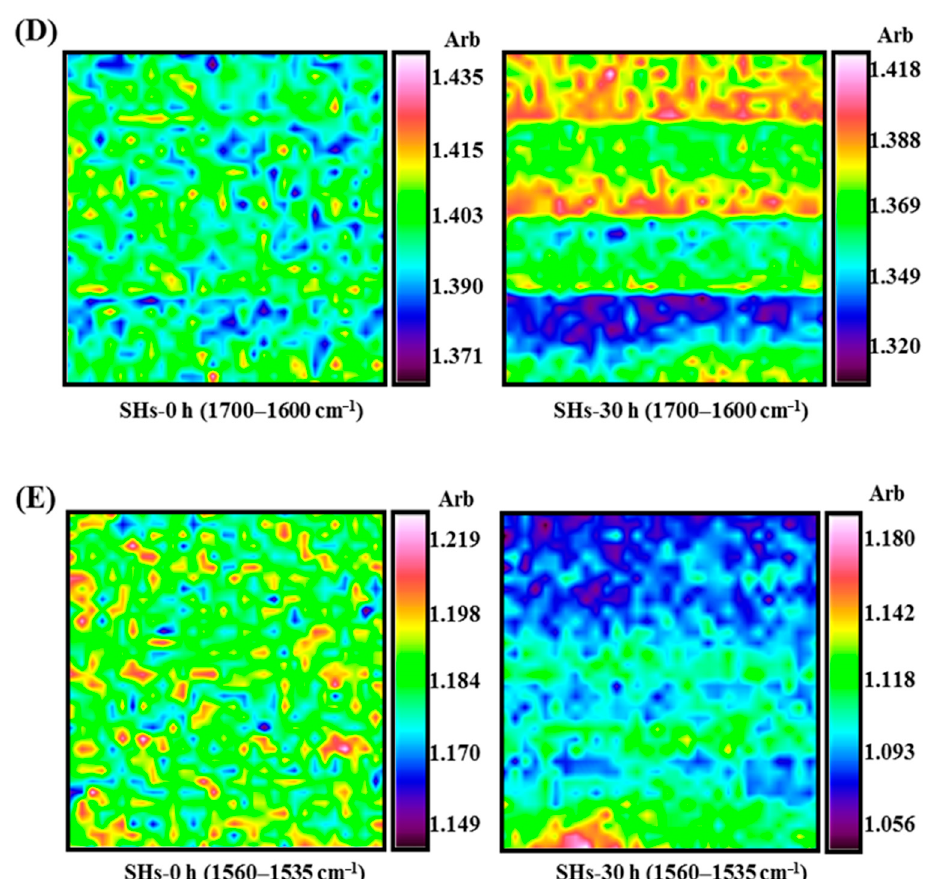
Figure 4. ( A ) Mid-infrared spectra of SHs-0 h and SHs-30 h. ( B – E ) Infrared microimaging spectra at 4000–750 cm − 1 , 3500–3250 cm − 1 , 1700–1600 cm − 1 and 1560–1535 cm − 1 of SHs-0 h and SHs-30 h.